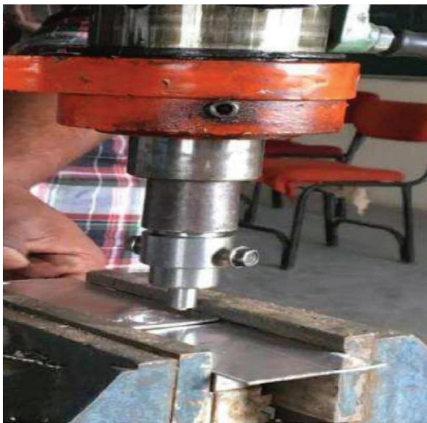
Figure 3: Friction stir